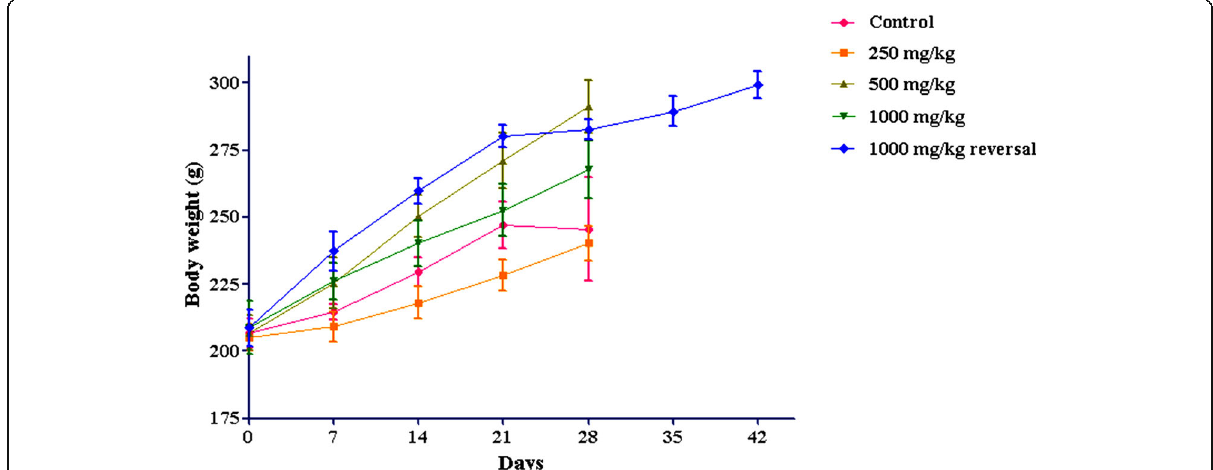
Fig. 3 Effect of 28-day treatment with Asdamarin. on body weight of male rats. Values are expressed as mean ± s.e.m. (n = 5). * p < 0.05 were considered significant using one-way Anova